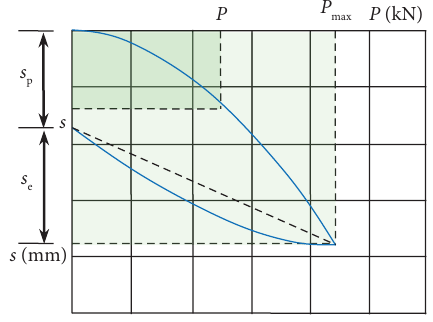
Figure 5: Elastic and plastic deformation of a single pile.